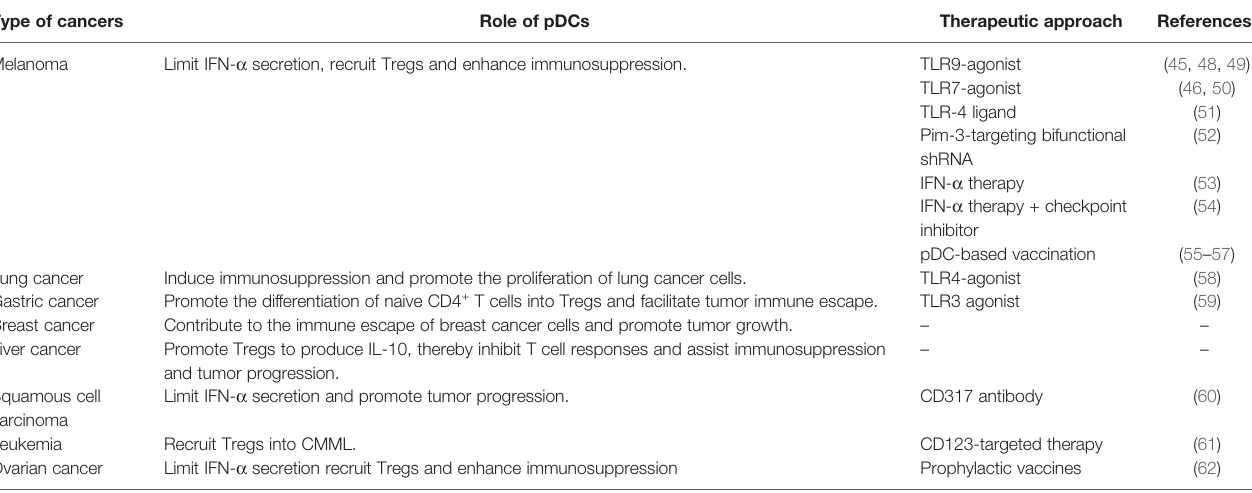
TABLE 1 | Therapeutic approaches for various cancers through